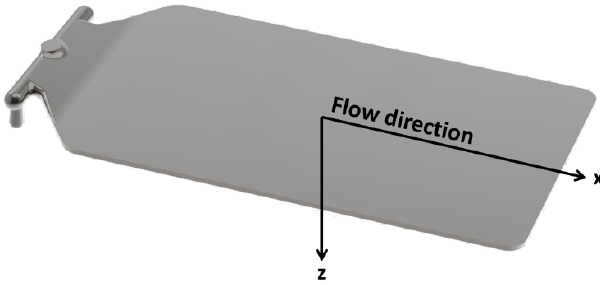
Figure 1. Schematic sketch of the sample with the testing and flow directions.